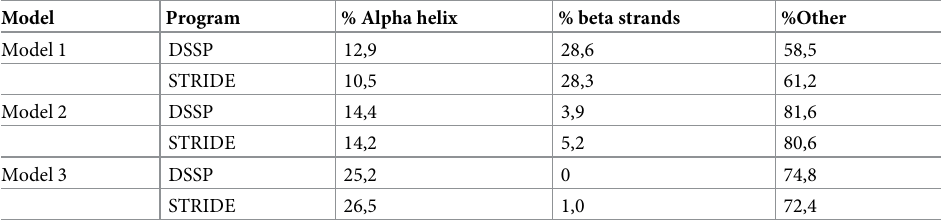
Table 3. Prediction of alpha-helical and beta-strand protein content for I-TASSER predicted structures of RBBP6 p53BD.